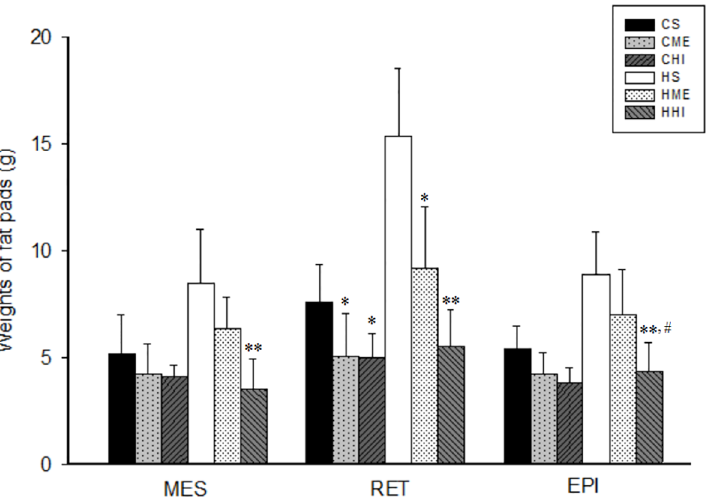
Fig 2. Comparisons of fat pad weights in different regions. RET weight was lower in CME and CHI rats comparedto CS rats ( P < 0.05). Fat pad weights in the MES, RET, and EPI regions were lower in the HHI group comparedto the HS group ( P < 0.01). RET fat weight was lower in the HME group than in the HS group ( P < 0.05) and EPI fat weight was higherin the HME than in the HHI group. MES, mesenteric region; RET, retroperitoneal region; EPI, epididymal region. CS = control diet and sedentary; CME = control diet with ME exercise; CHI = control diet with HI exercise; HS = high-fat diet and sedentary; HME = high-fatdiet with ME exercise; HHI = high-fat diet with HI exercise. Statistical significanceusing one-wayANOVA: * vs sedentary group ( * , P < 0.05; ** , P < 0.01); # vs the ME group (#, P < 0.05).